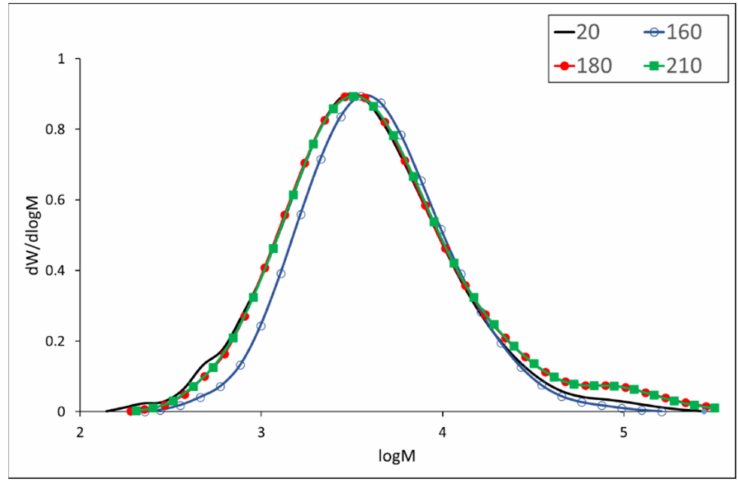
Figure 3. Molecular weight distribution of merbau wood